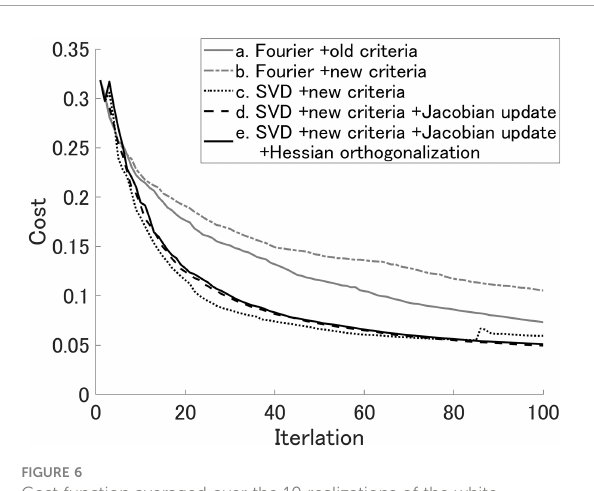
FIGURE 6 Cost function averaged over the 10 realizations of the white Gaussian